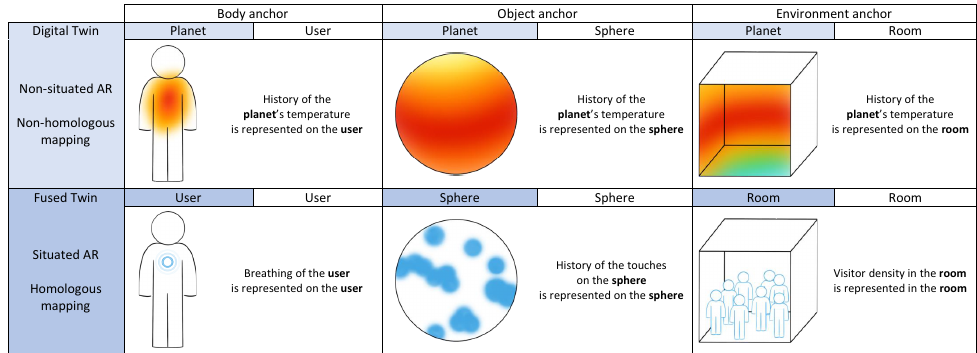
Figure 6. Examples of Embodied Digital Twins and Fused Twins . We observe the difference between non-situated AR (top row) and situated AR (bottom row) for anchoring content at the body of the user, an object, or the immediate environment. The distinction between body-, object-, and environment-centred AR is inspired by the classification of different physicalities of embodiment offered by [90,91]. With a body anchor, the DT is anchored on the users’ bodies, similar to the directly embodied approach. With an object anchor, the DT is anchored on an object with which the user can interact, similar to the manipulated approach. With an environment anchor, the DT is anchored in a room, similar to the augmented approach. In the situated environment (implementing the FTs paradigm), the relationship between the DT and the representation is homologous such that the body, object, or environment is used to anchor its own DT in a one-to-one correspondence. However, in the non-situated environment, this relationship is non-homologous because the mapping from the DT to the representation is transformation instead of a one-to-one